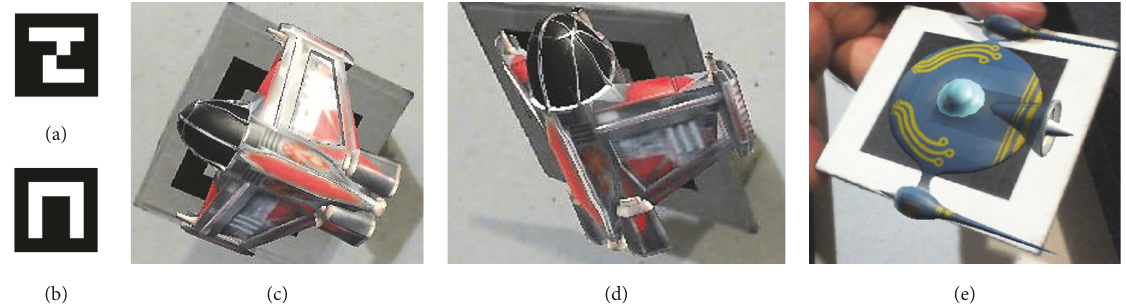
Figure 12: (a) and (b) diverse 2D geometric patterns; (c), (d) associated Microsoft XNA 3D model with pattern (a); (e) associated Microsoft XNA 3D model with pattern (b)